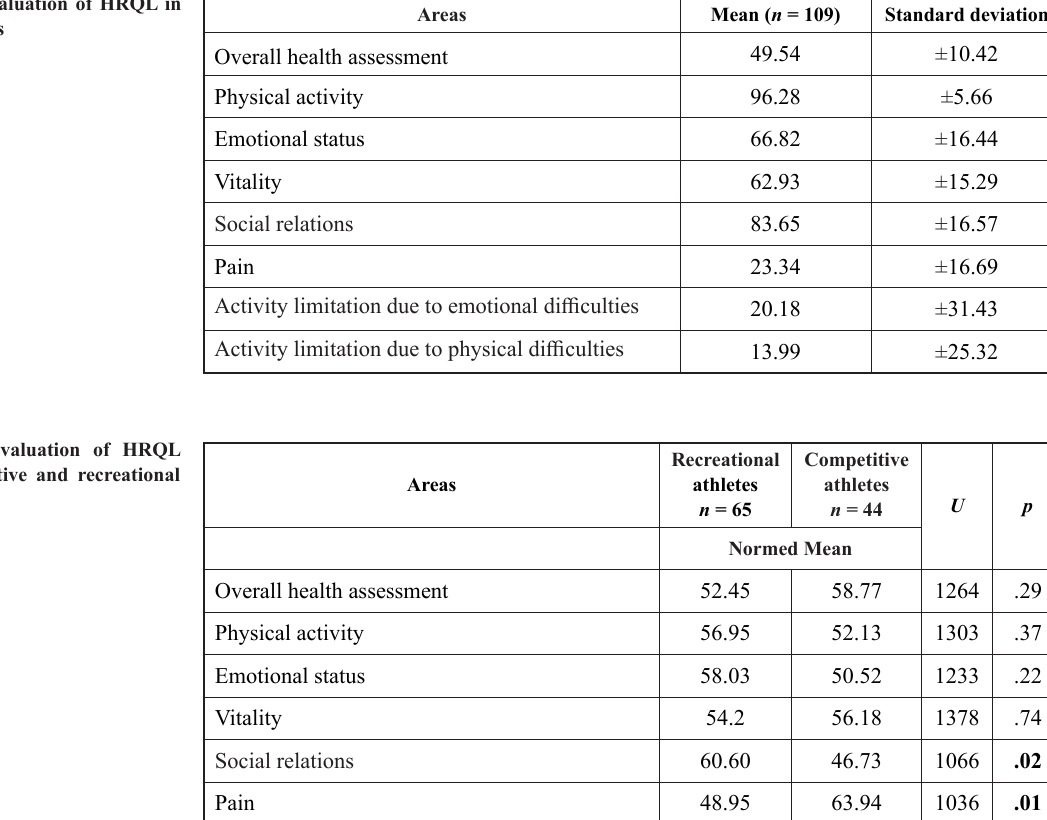
Table 1. Evaluation of HRQL in participants